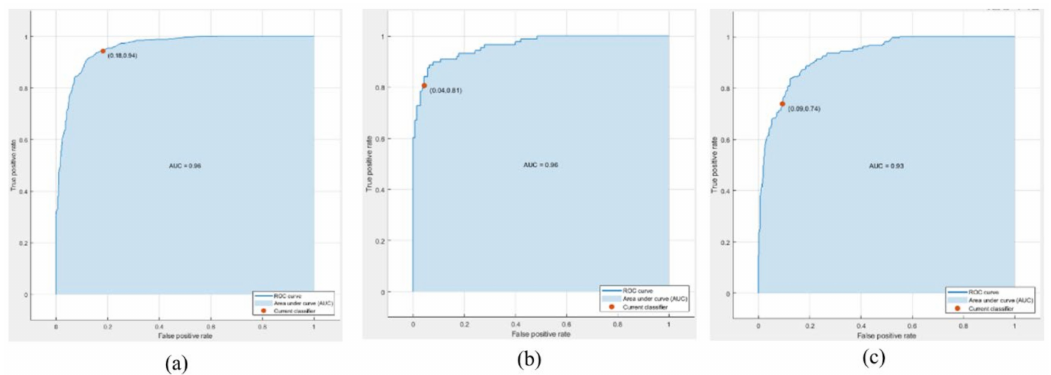
Figure 17. ROC curves and AUC values showing best outcomes of ( a ) mixed views with CSVM, ( b ) back views with CSVM, and ( c ) front views with CSVM of PKU-Reid dataset utilizing 1000-feature